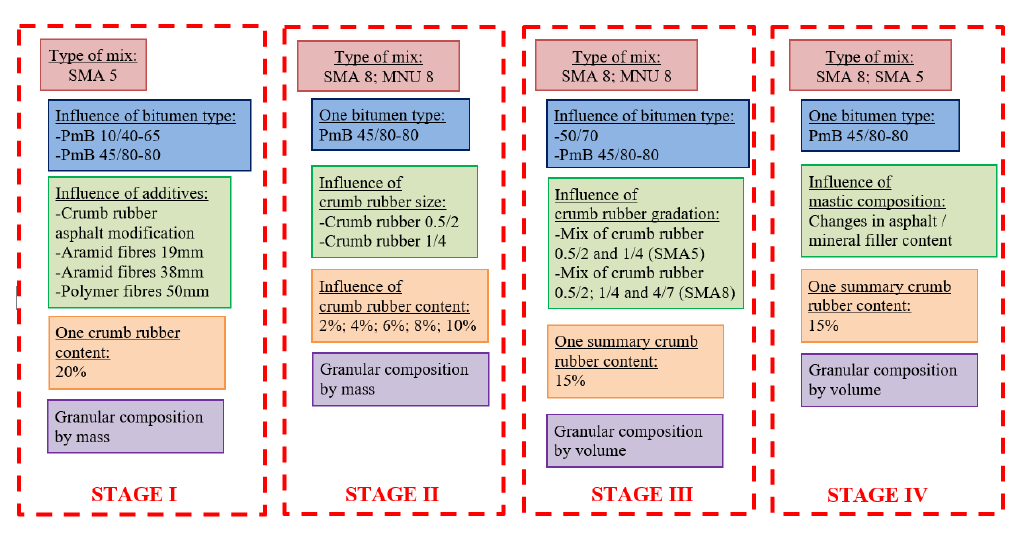
Figure 2. Diagram of poroelastic Safe, Eco-friendly POroelastic Road Surface (SEPOR) mixtures mix design process.